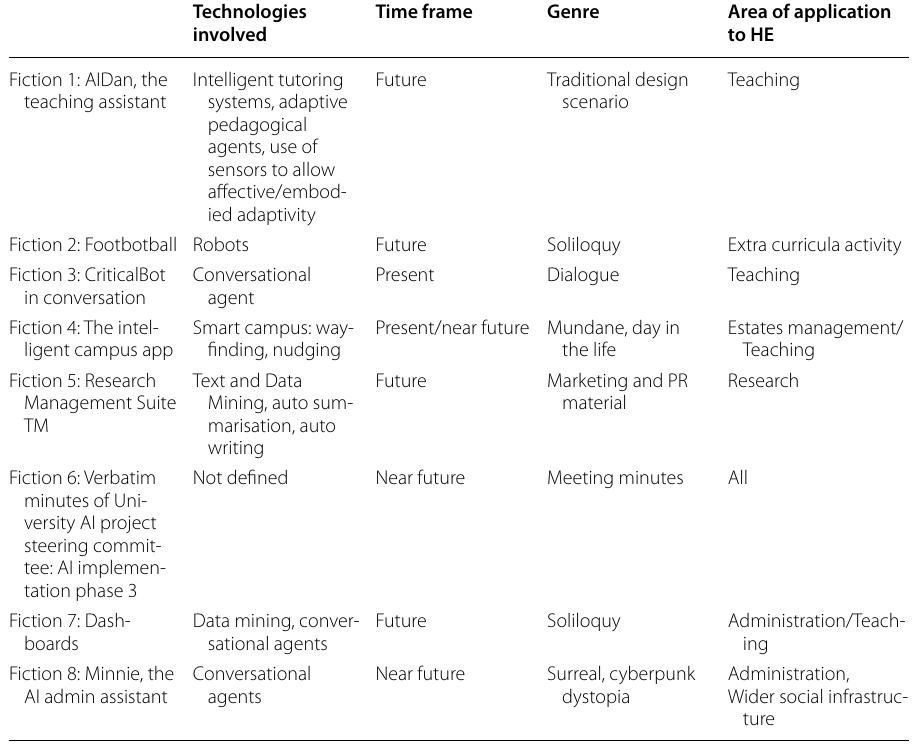
Table 1 Summary of the design fictions Technologies Time frame Genre Area of application involved